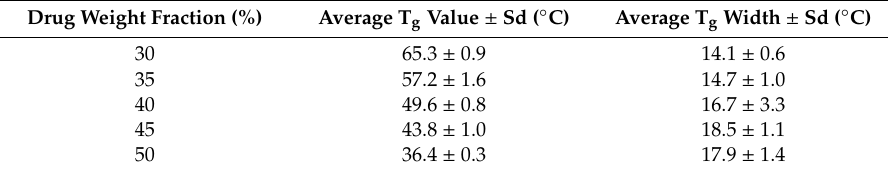
Figure 3. ( A ) mDSC thermograms of milled MIC-PVP-VA coated beads (BC), with drug loadings from 30% (black) to 50% (green) by intermediate steps of 5%. The RHF signals are shown as arbitrary units; ( B ) corresponding XRPD diffractograms and the diffractogram of pure microcrystalline cellulose (MCC) beads (dark blue) as comparison. The intensities are shown as arbitrary units. Table 2. Average T g values and widths ± standard deviation (sd) for MIC_PVP-VA_MeOH coated beads. Average T m,onset values and melting enthalpies ± sd do not apply for the coated beads, since no crystallinity could be detected for any formulation.